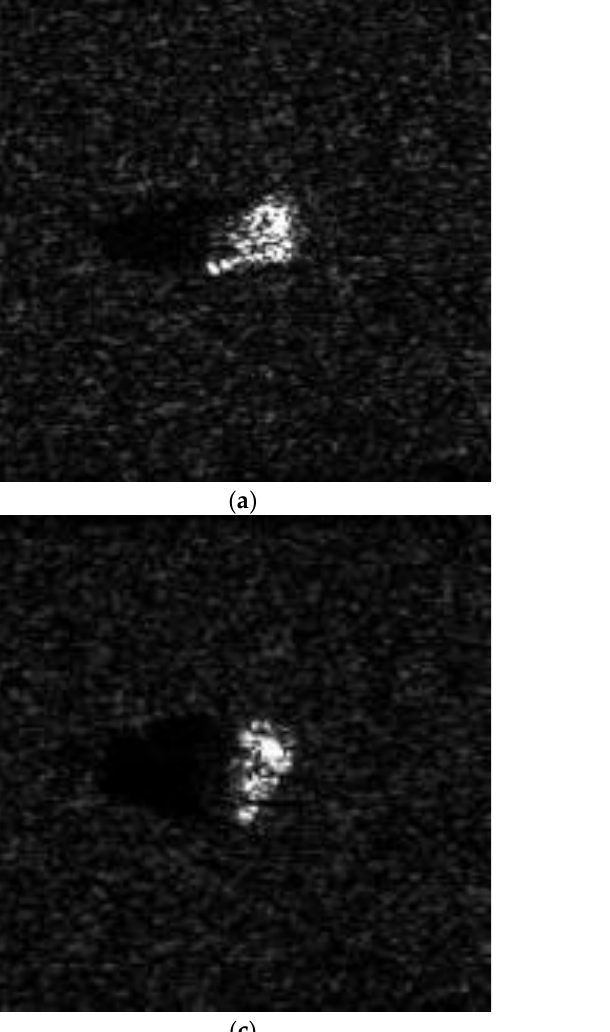
◦ simulated image; a = 15